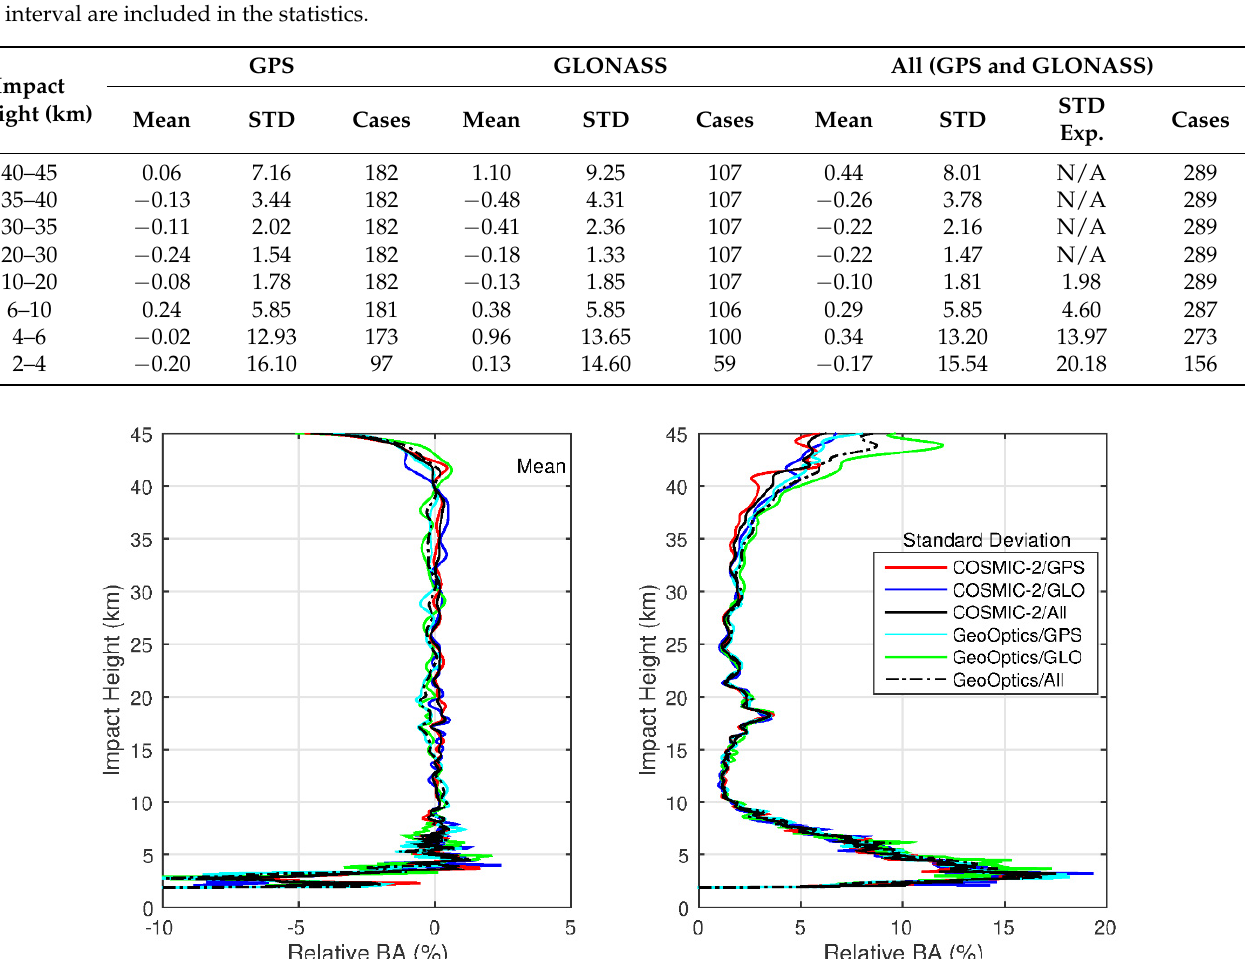
Figure 16. Bending angle profile statistical comparison with simulated BA profiles using ERA5 for all 289 SRO cases (182 for GPS and 107 for GLONASS): ( left ) overall mean relative BA difference between observation and simulation using ERA5 and ( right ) standard deviation.